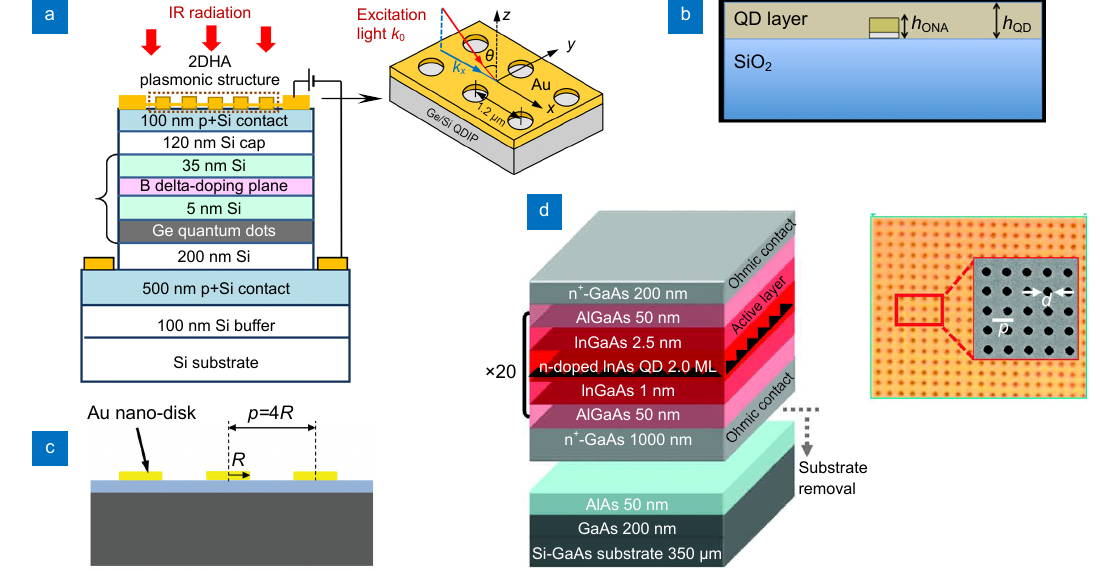
Fig. 8 | Schematic diagrams of plasmonic quantum type detectors. ( a ) 2DSHA gold structure fabricated on the Ge/Si QDIP. ( b ) Au nano- antenna embedded in the QD layer on SiO 2 substrate. ( c ) Plasmonic nano-disk arrays on QDIP. ( d ) Plasmonic hole array patterned on top of the DWELL detector. Figures reproduced from: (a) ref. 31 , AIP Publishing; (b) ref. 53 , AIP Publishing; (c) ref. 54 , The Royal Society of Chemistry; (d) ref. 56 , Macmillan Publishers